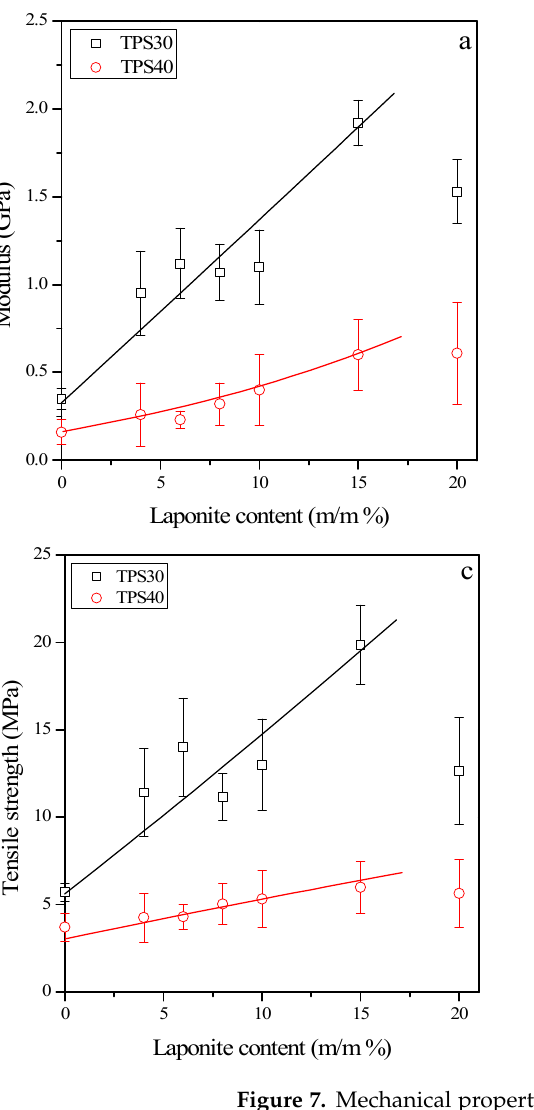
Figure 7. Mechanical properties: effect of laponite ( a , c ) and montmorillonite ( b , d ) content on the stiffness ( a , b ) and strength ( c , d ) of TPS/clay nanocomposites.